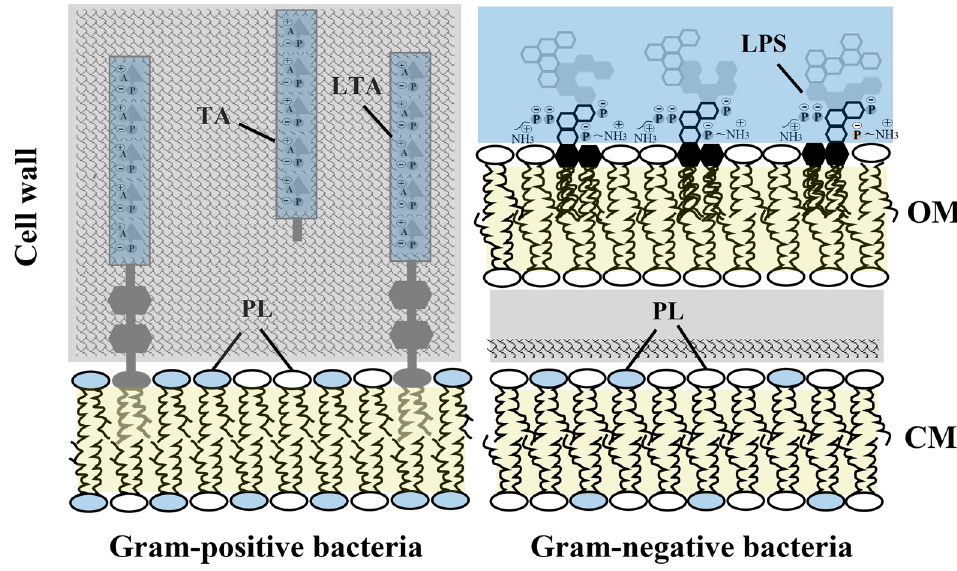
Figure 1. Peptide sequences. Distribution of amino acid residues in OP-145 and SAAP-148. Both peptides are N-terminally acetylated and C-terminally amidated, which is not shown in the pictures above. The hydrophilic residues are shown on top and hydrophobic on bottom as illustrated by Peptide Property Calculator (https://pepcalc.com/, accessed on 1 May 2022). Color code: acidic (red), aromatic (green), cationic (blue), aliphatic (grey), and polar (dark green).